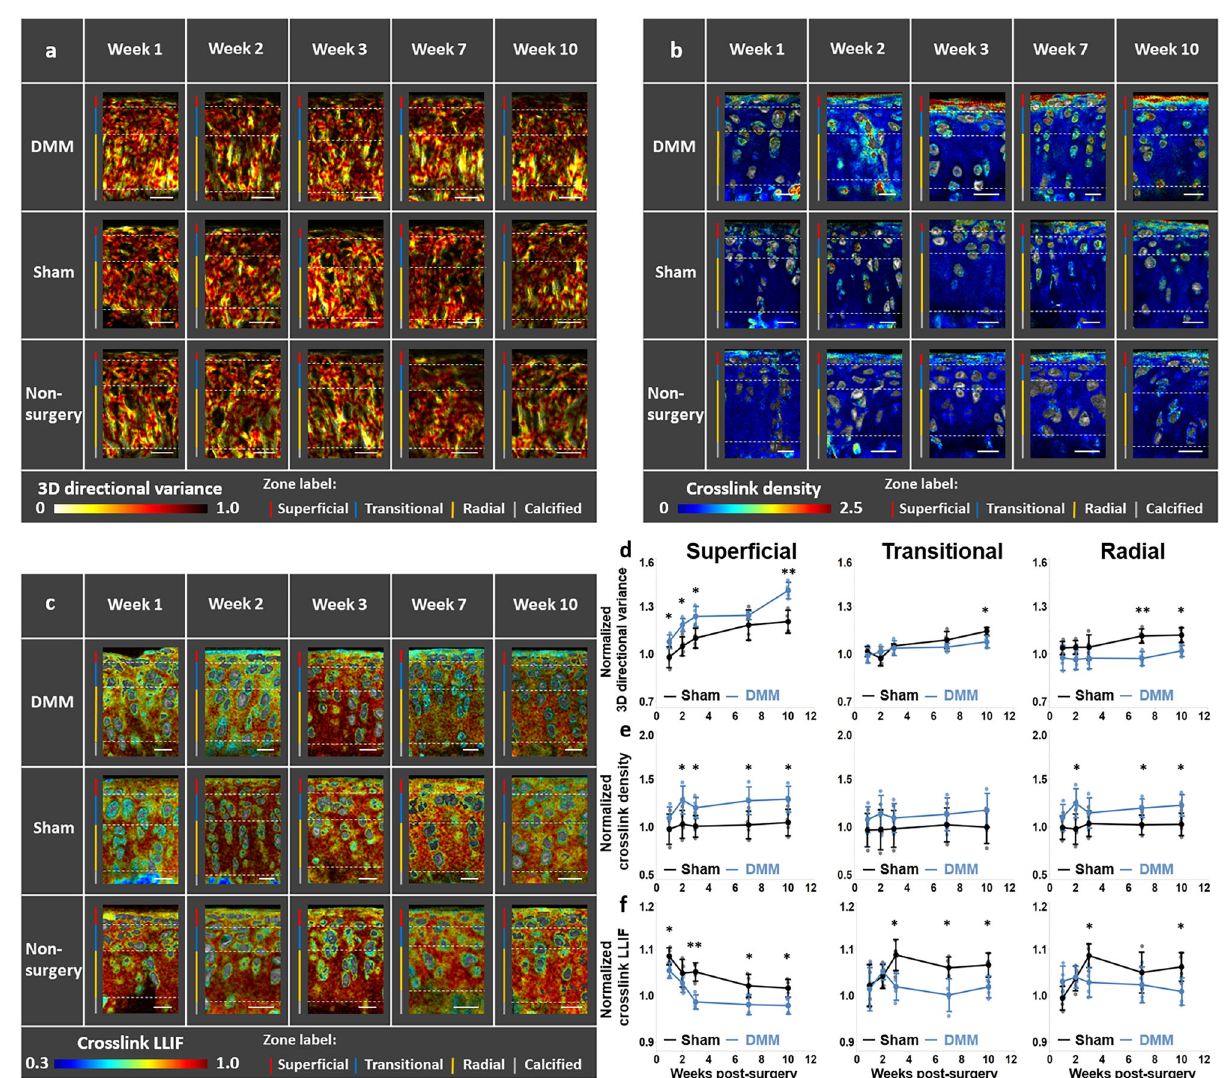
Fig. 2 Optical metrics acquired from ECM label-free imaging at early stages of osteoarthritis. Representative maps of a 3D directional variance, b cross- link density, and c cross-link LLIF of the DMM (top), sham (middle), and non-surgery control (bottom), at 1, 2, 3, 7, and 10 weeks post-treatment. Different zone regions are indicated by different colors on the line adjacent to the specimens. The mean and standard deviation of d 3D directional variance, e cross- link density, and f cross-link LLIF normalized to non-surgery controls at different time points and distinct zones. * p < 0.05 and ** p < 0.01. n = 4 mice for each group. Scale bar: 30 μ